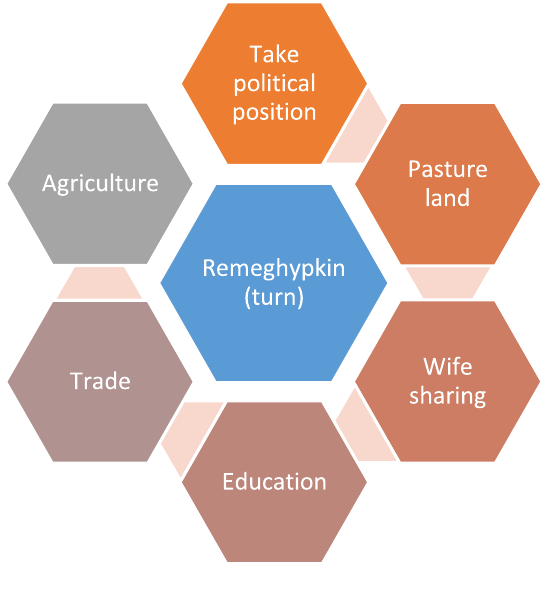
Fig. 2 The Reme gyapkin,